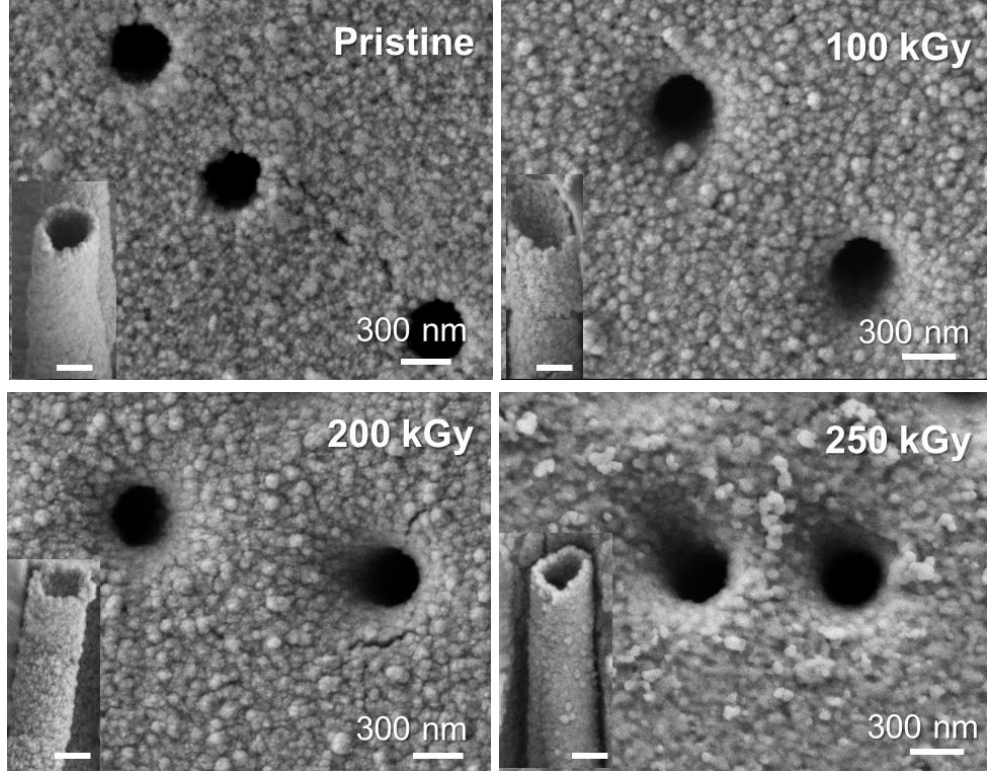
Figure 1. Scanning electron microscopy (SEM) images of the composite membrane’s surface and individual released Cu nanotubes (inset, scale bar: 200 nm).